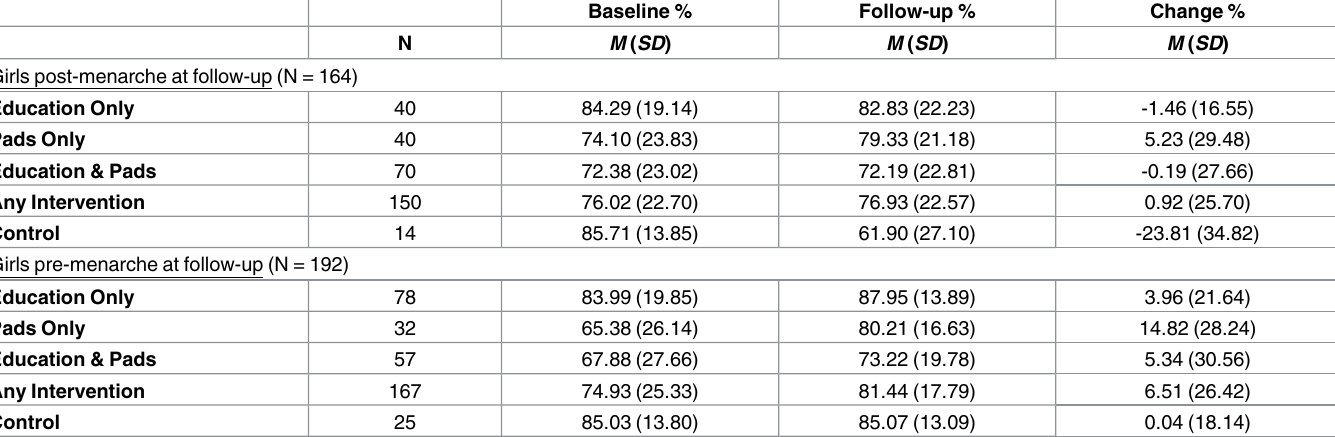
Table 5. Mean percentage attendance at baseline, follow-up and change scores across conditions for menstruating and non-menstruating girls at follow-up (n =